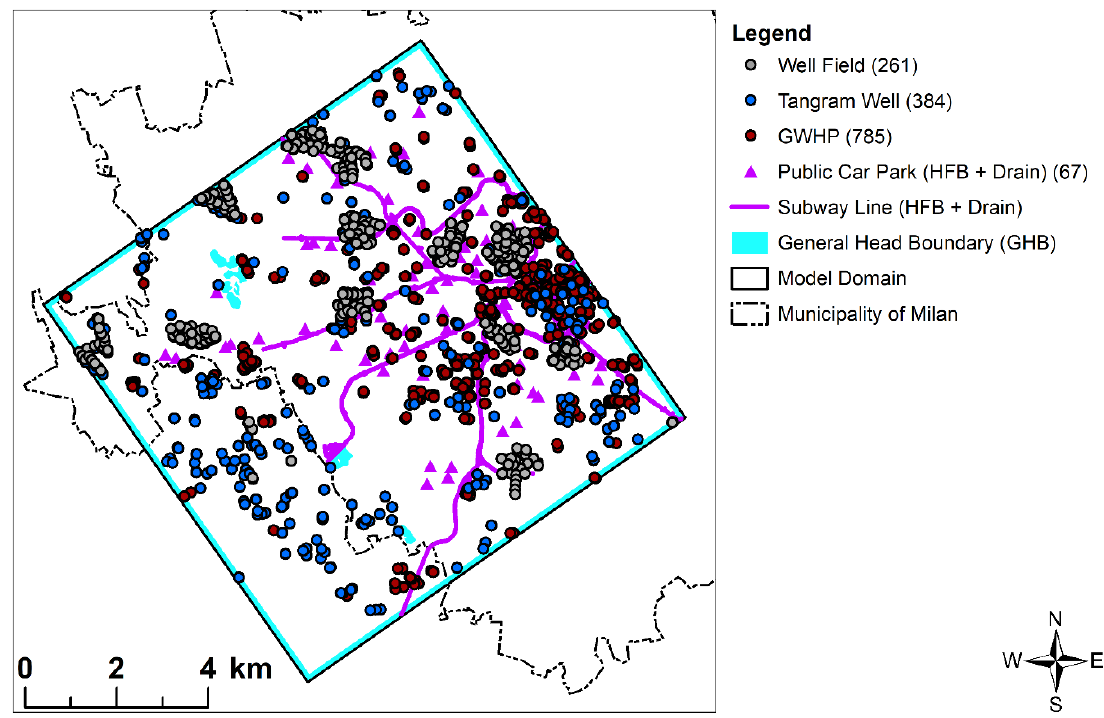
Figure 4. Model boundary conditions. GHBs’ distance from the model area has been indicated. Please note that color coding of the infrastructural elements (subway lines and underground public car parks) refers to the HFB package color in Groundwater Vistas 8. Public car parks have been represented as triangles to differentiate them from wells.